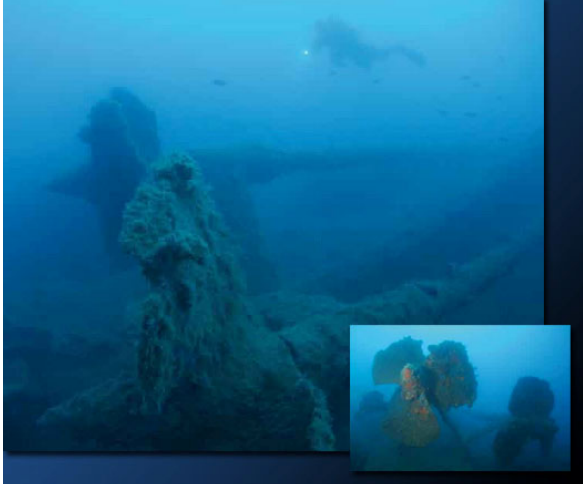
Figure 3: The screws of the “Intrepido” wreck (Ruperti